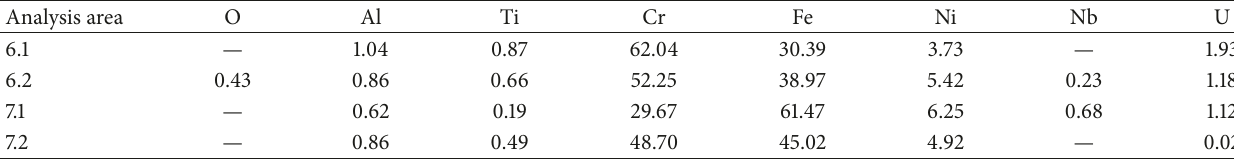
Table 3: Elemental composition of metallic contaminations on samples, mass %.